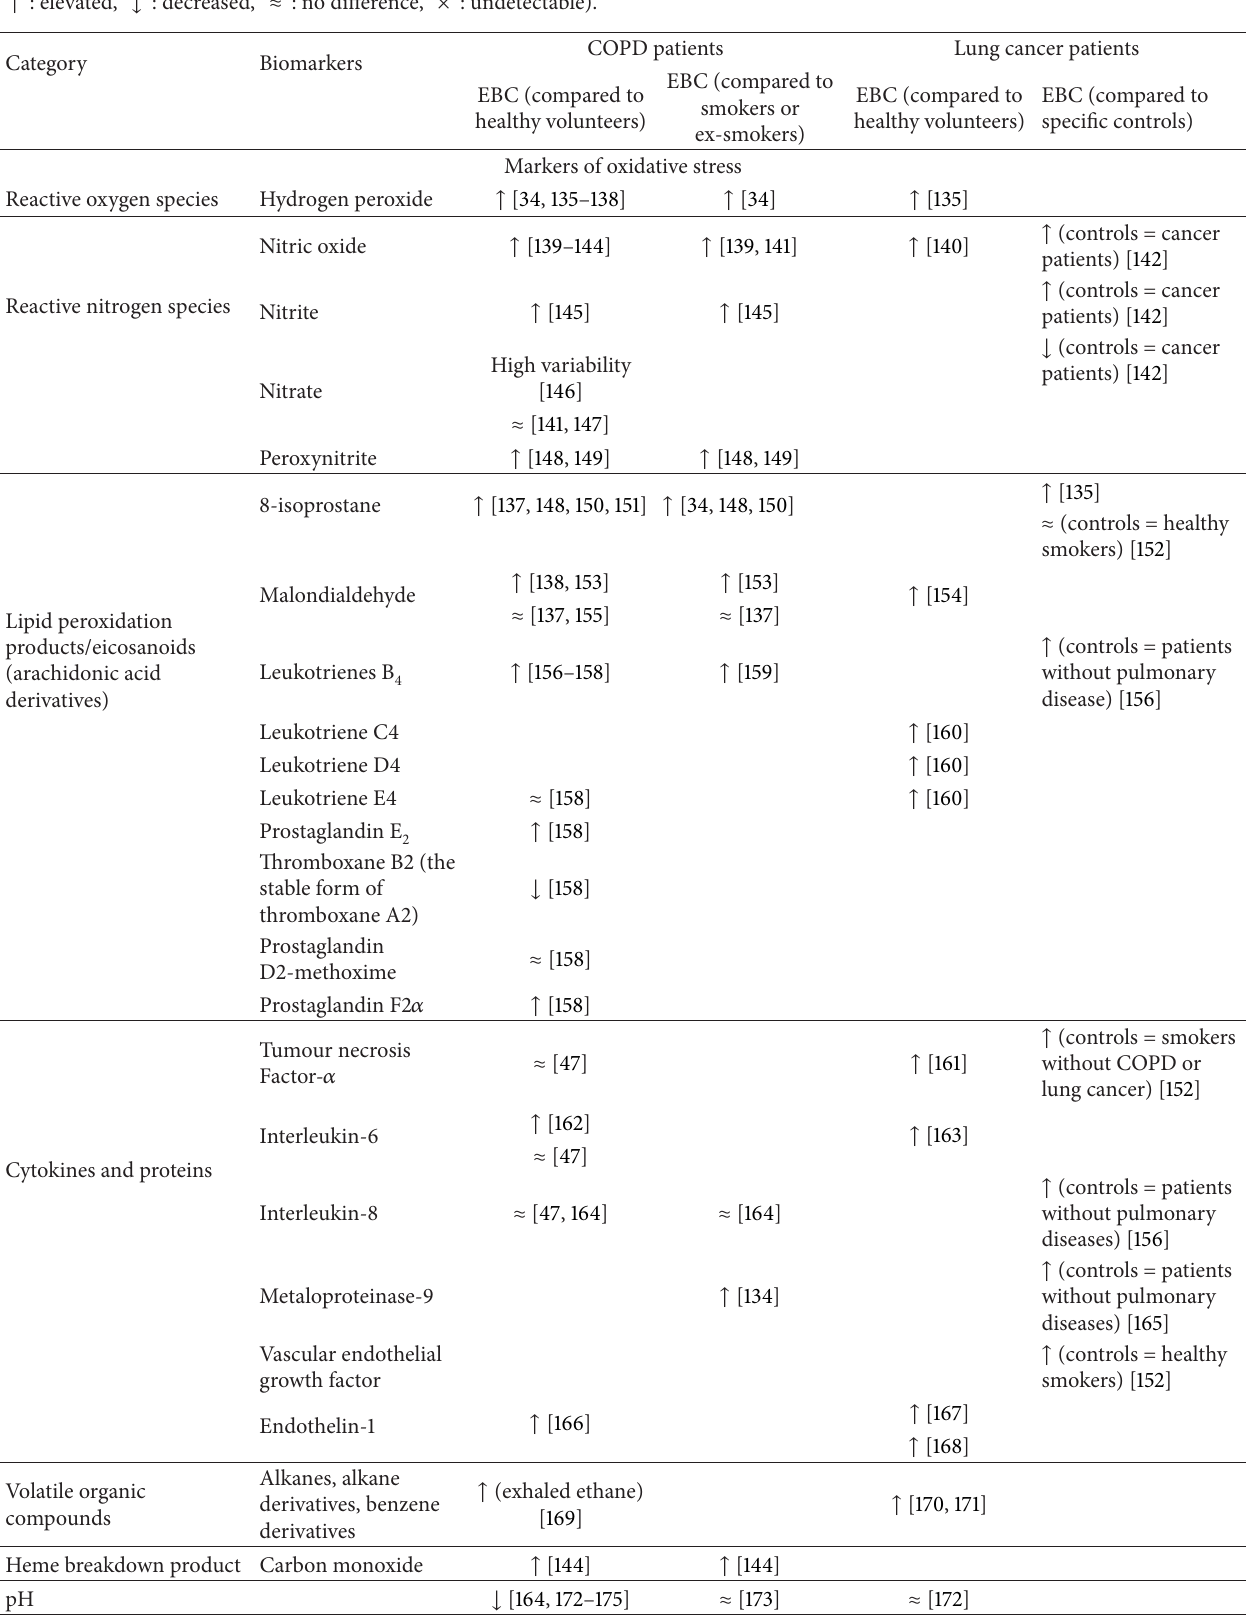
Table 1: Summary of EBC markers of oxidative stress and antioxidant capacity including S100 proteins in COPD and lung cancer (legend: “ ↑ ”: elevated, “ ↓ ”: decreased, “ ≈ ”: no difference, “ × ”: